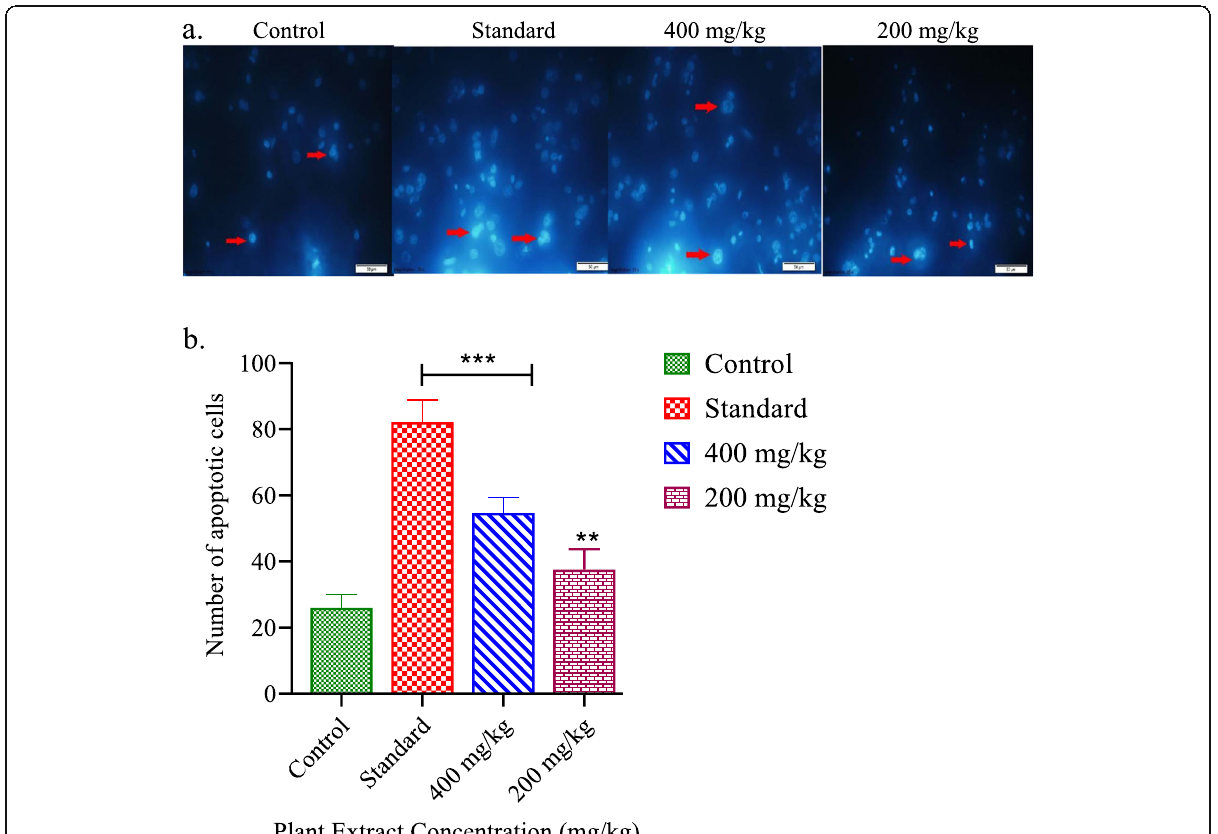
Fig. 3 a Detection of apoptotic cells using DAPI staining after treatment with Chenopodium album leaf extract in EAC cell bearing Swiss albino mice. b The number of apoptotic cells per slide was estimated by counting apoptotic cells after 6 days of treatment with Chenopodium album leaf extract in EAC cell bearing Swiss albino mice